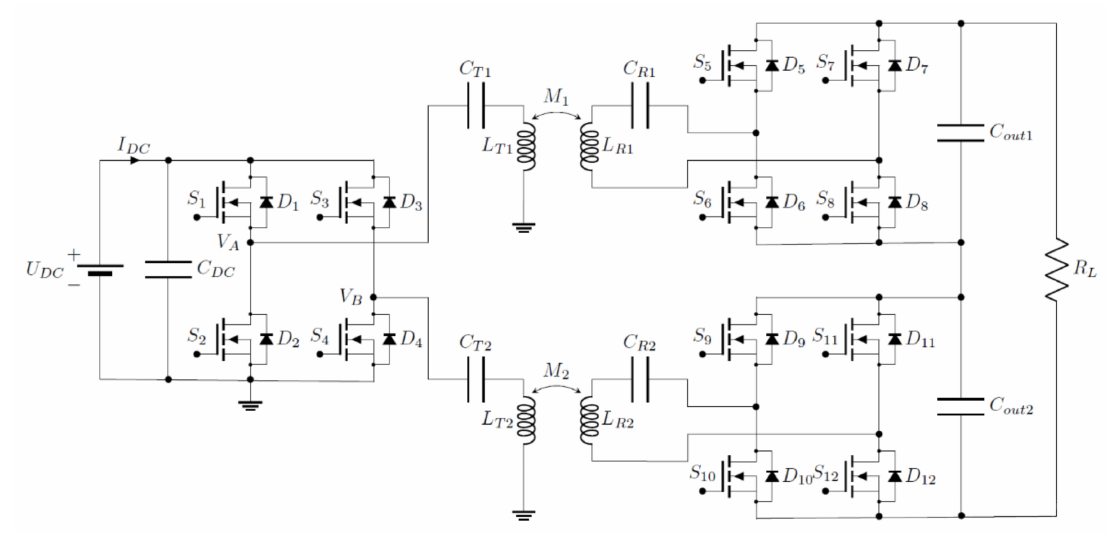
Figure 5. Circuit of a wireless power transfer